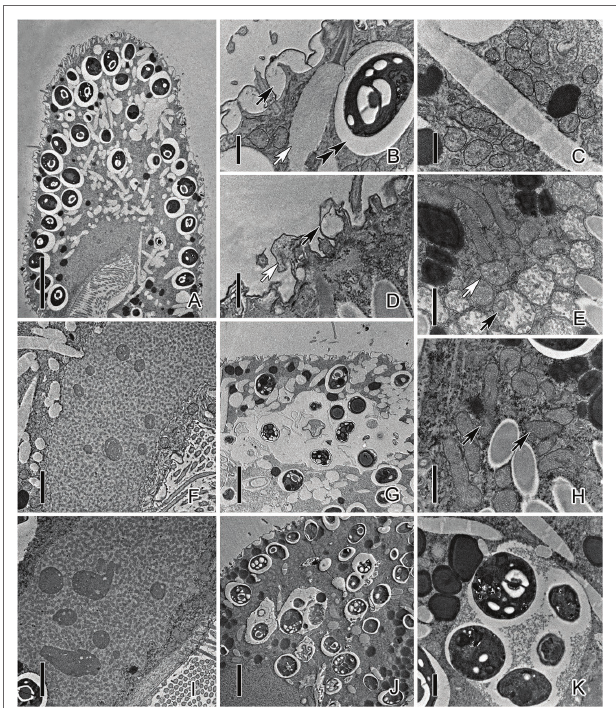
FIGURE 3 | Transmission electron micrograph images of P. bursaria under control and CuNP treatment. (A) The cell of P. bursaria under control. (B) The pellicular alveoli (black arrow), symbiotic algae, the PV membrane (double- arrowhead), and trichocyst (white arrow) in untreated P. bursaria . (C) The mitochondria of the control cell. (D) Granular substances (white arrow) or vesicular structures (black arrow) appeared in the pellicular alveoli of CuNP- treated cells. (E) Mitochondria were damaged to different degrees. The black arrow showed mitochondria obviously swollen, and the white arrow showed slight swelling. (F) The macronucleus of the untreated cell. (H) Arrows denote that the membranes of mitochondria were incomplete after treatment. (I) The macronucleus of CuNP treatment cell with nucleoli increased. (G,J,K) The symbiotic algae were digested in the DV of P. bursaria after treatment. Scale bars = 10 μ m (A) , 5 μ m (G,J) , 2 μ m (F,I) , and 1 μ m (B–E,H,K)